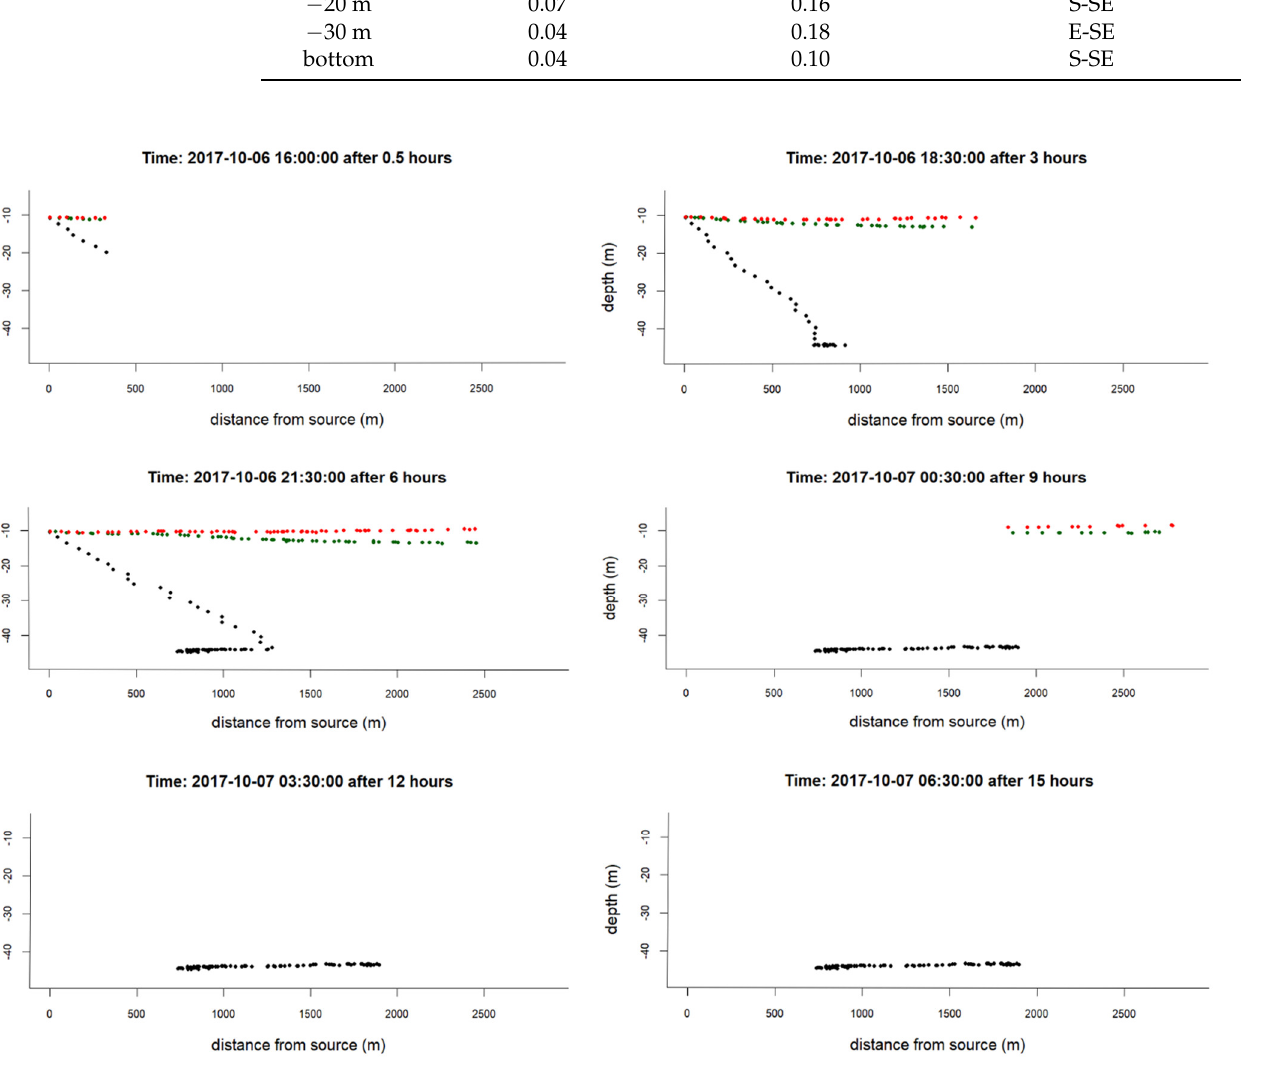
Figure 16. Plt A vertical cross section of PW discharged: trajectories and deposition on the seabed of PW suspended particulate matter (clay—red line, silt—green line, sand—black line) during a continuous discharge event (every 3 h from 6 October 2010 16:30 to 7 October 2010 03:30 by MIKE 3 PT module output) Discharge point at the upper left corner of the figure.